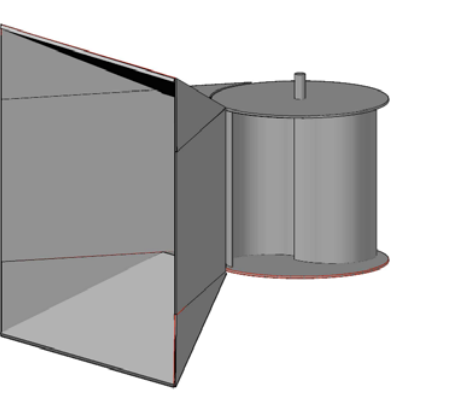
Figure 7 – Vertical change of the wind inlet